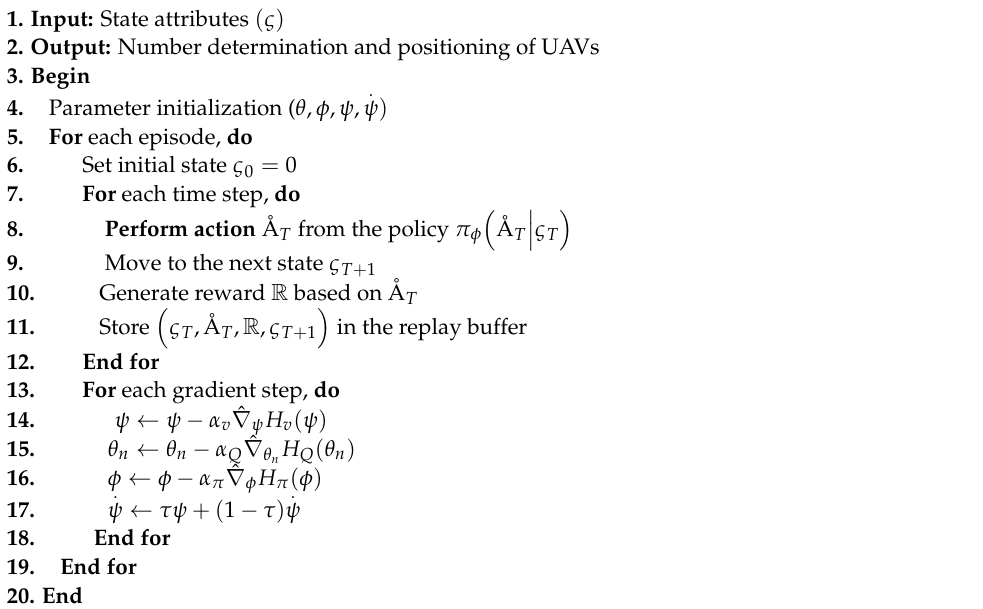
Algorithm 3 DPSAC ‐ based UAV positioning.